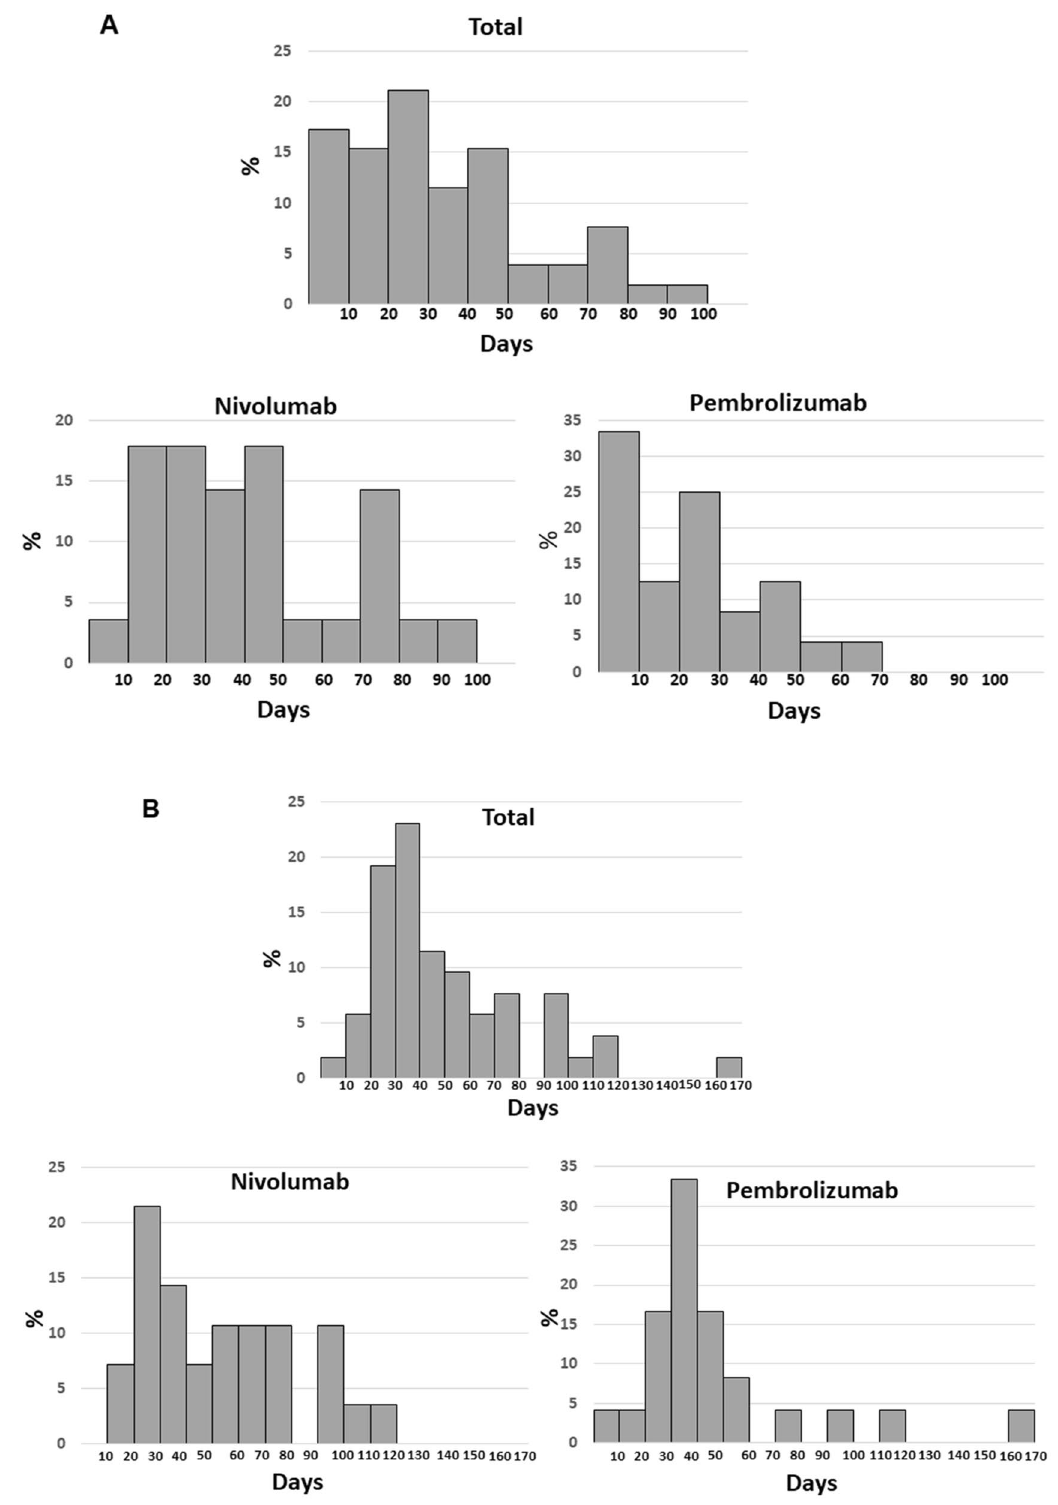
Figure 4. ( A ) Timing of the serum ALT increase in responders. ( B ) Variations in the timing of the response after the serum ALT increase in